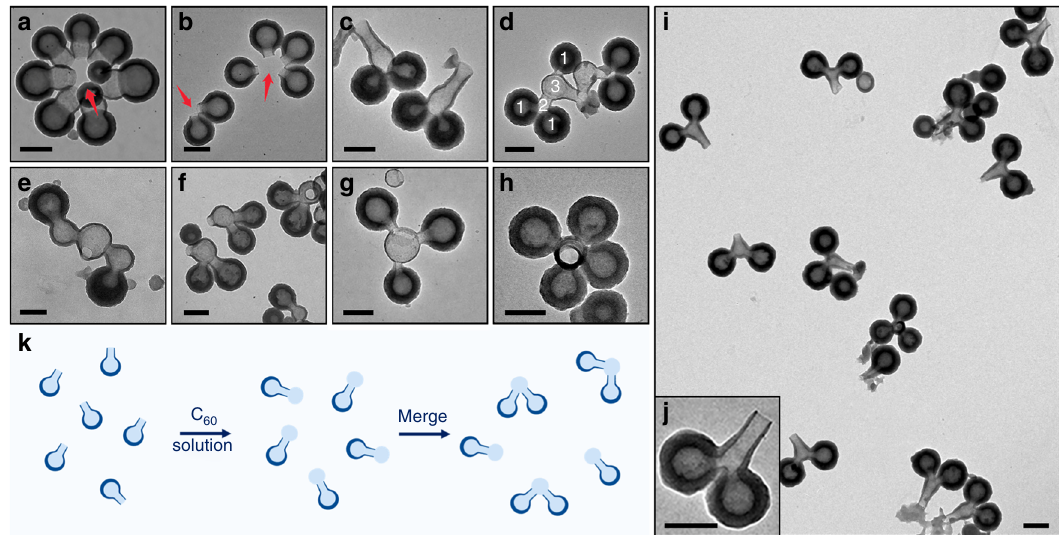
Fig. 5 Connection of hollow units. TEM images of a , b C 60 nanocucurbits and bottles arranged in a circle; c dimers of connected nanobowls; d connection between a dimer of nanobowls and a nanobottle; e dimers of connected nanocucurbits; f – h dimers, trimers, and tetramers of nanobottles, respectively; i large area dimers of nanobottles, and j typical connected nanobottles. k Schematics illustrating the connection of nanobottles via the droplet at their opening. Scale bars are 200